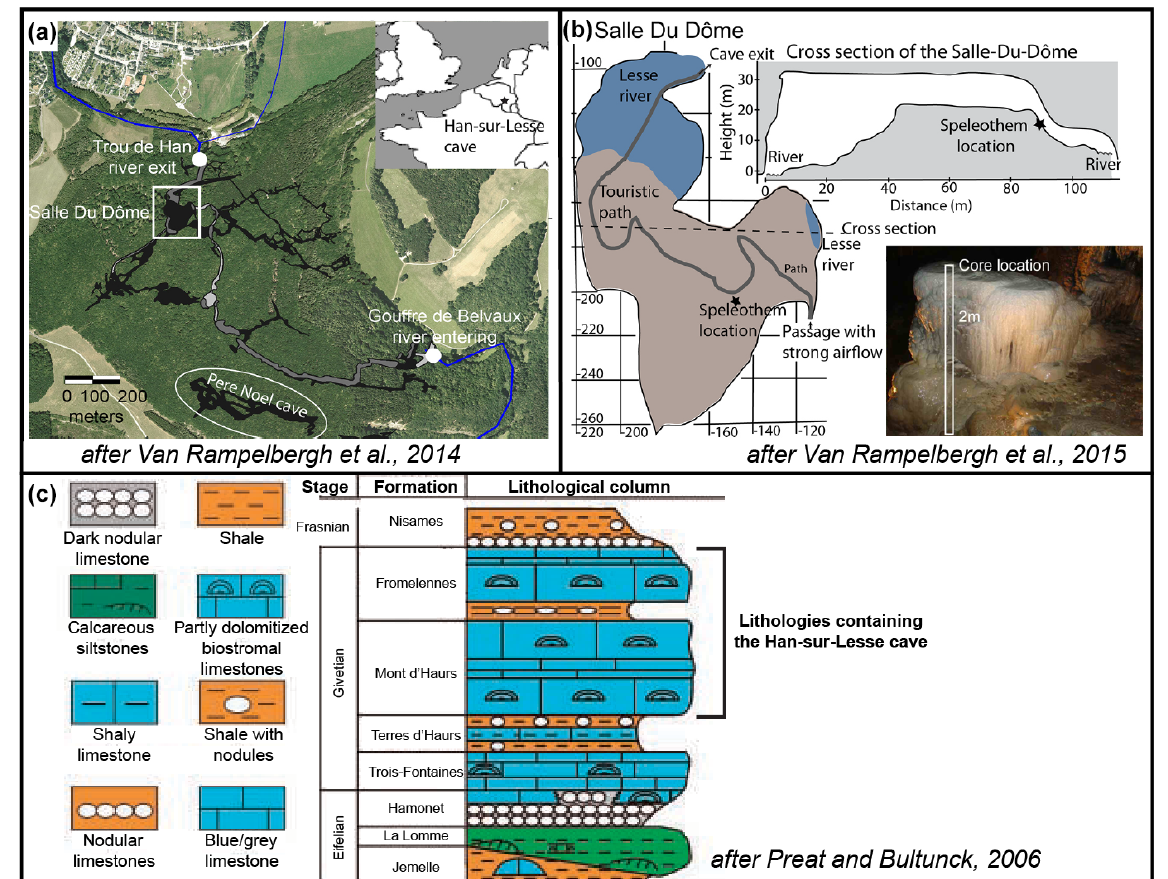
Figure 1. (a) Location of the Han-sur-Lesse cave system (50 ◦ 06 (cid:48) 51 (cid:48)(cid:48) N, 5 ◦ 12 (cid:48) 12 (cid:48)(cid:48) E) with the entrance and exit of the Lesse River, the Salle-du-Dôme and the Père-Noël Cave. North is upwards. (b) Map showing the location of the Proserpine stalagmite within the Salle- du-Dôme. The insert shows the position of the core retrieved from the speleothem. Images adapted from Van Rampelbergh et al. (2014, 2015). (c) Lithological column of the Devonian strata in the Synclinorium of Dinant including the two formations (Fromellennes and Mont d’Haurs) in which the Han-sur-Lesse cave is situated. Note the presence of partly dolomitized biostromal limestones and shales in both these